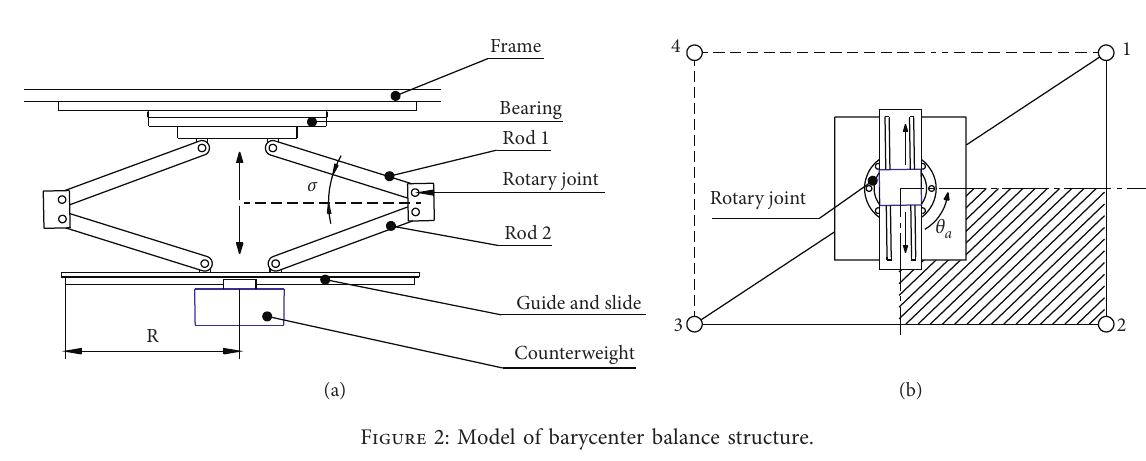
Figure 2: Model of barycenter balance structure.